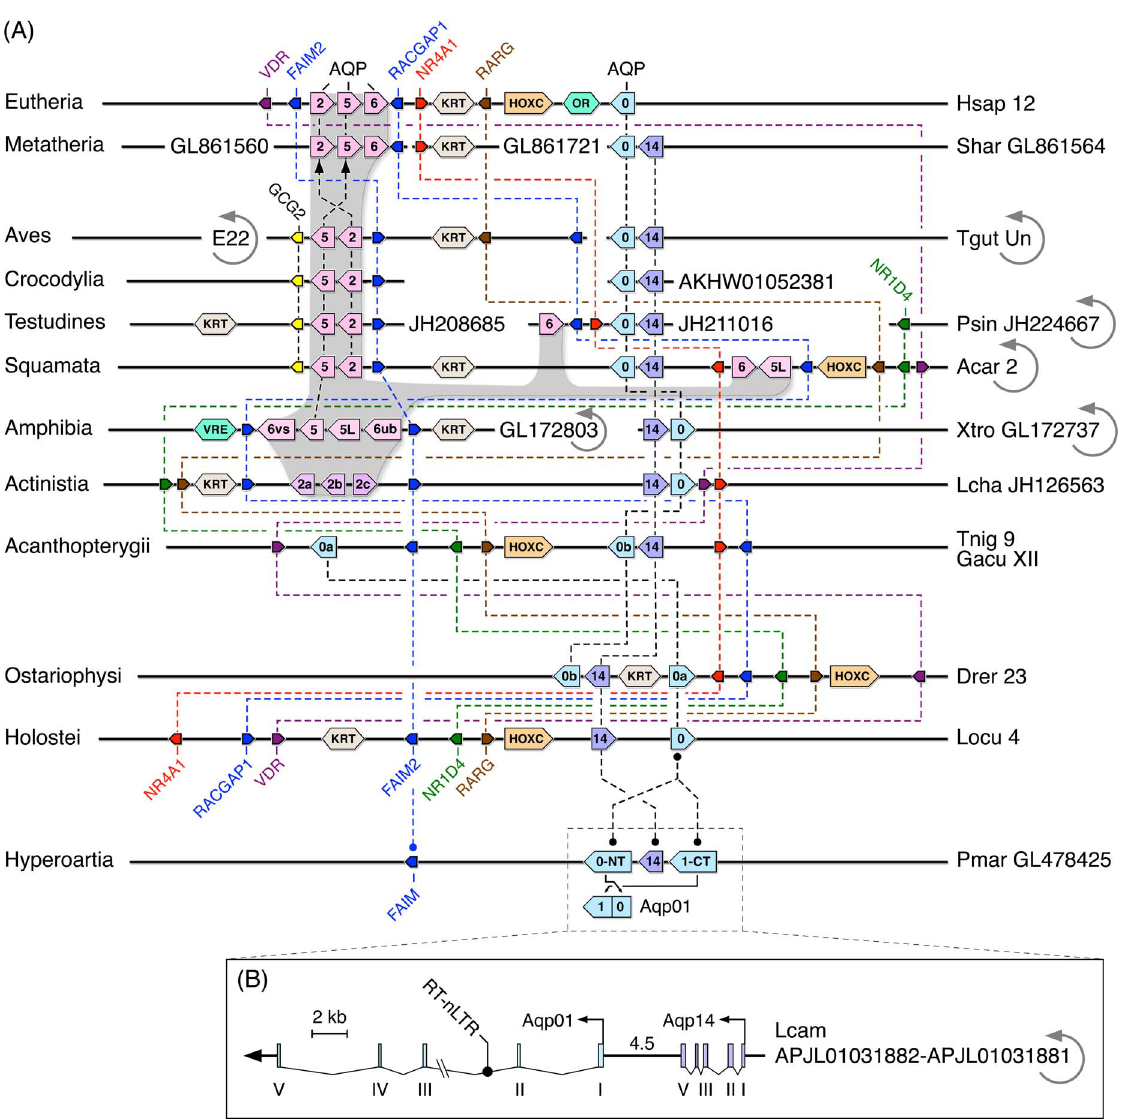
Figure 3. Syntenic arrangement of the vertebrate aquaporin gene clusters. ( A ) Synteny is shown in relation to conserved nuclear receptors, and the keratin (KRT), olfactory receptor (OR), vomeronasal receptor (VRE), homeobox C (HOXC) superclusters. Circular arrows indicate that the linkage group is flipped, and coding direction is indicated by the pointed end of the gene symbols. ( B ) Genomic structure of the Arctic lamprey aqp01 and -14 paralogs.